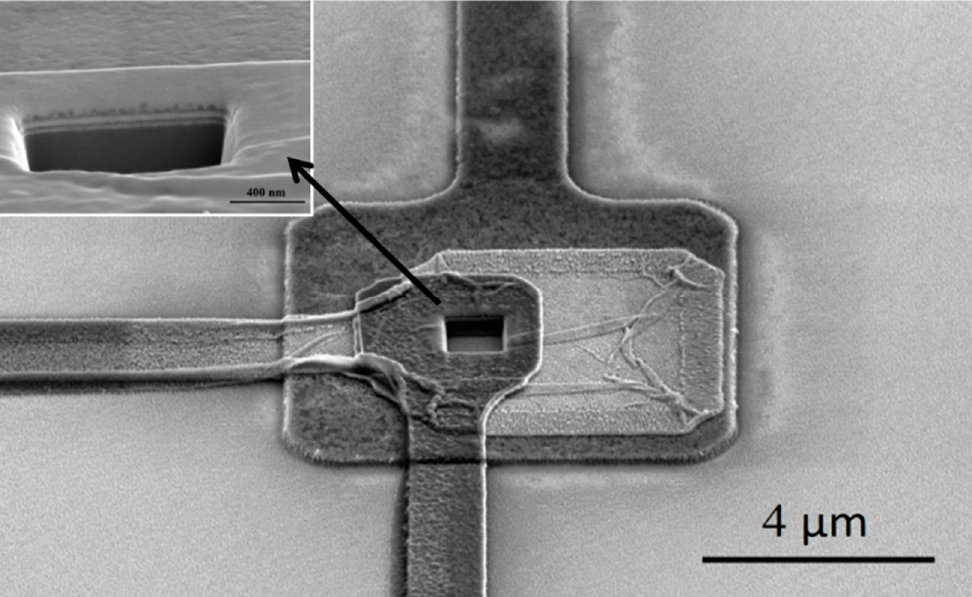
Figure 2. Scanning electron micrograph of active part of the device. The illustration shows the multilayer film structure (at 20° tilt to horizontal), which is consistent with Figure 1.